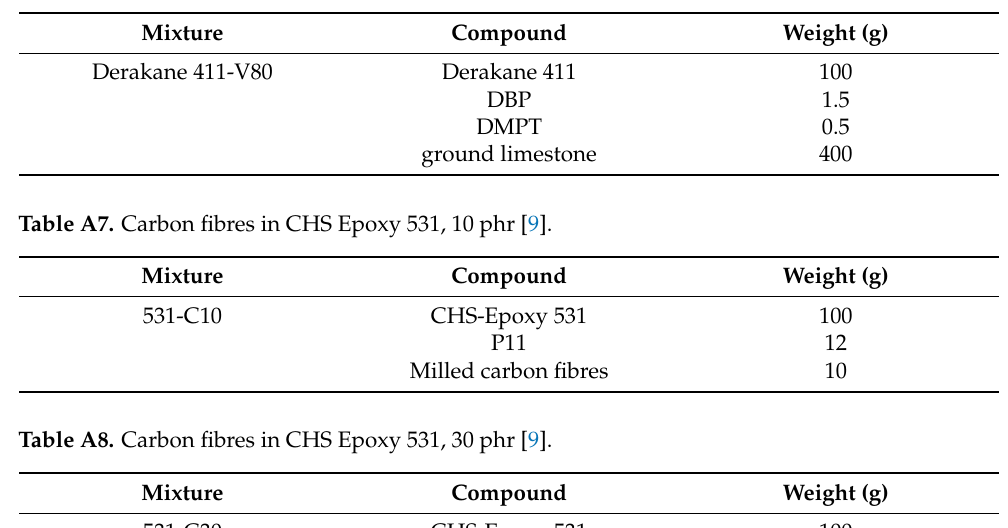
Table A6. Grounded limestone filler in Derakane 411 [9].